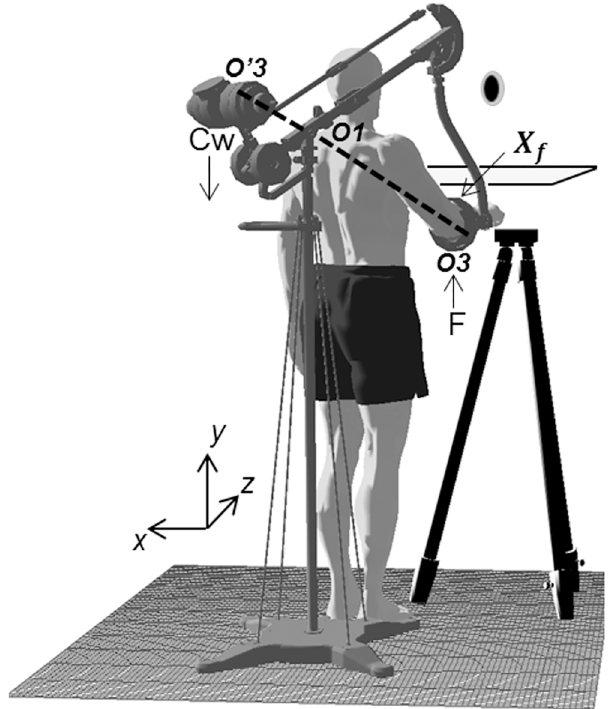
Fig 1. Apparatus. Trackhold (TH) device and subjects ’ arm posture at the moment of force detection, namely when the black sphere (i.e. cursor) was within the gray sphere (i.e., target). Cw represents the load applied on the device balancer. F indicates the consequent upward force exerted on subjects ’ arm ( F = CW /3). Xf is a distance from elbow joint representing the point of force application on subjects arm. O 3 is the contact point between subject ’ s arm and TH (cradle), O1 is the fulcrum of TH horizontal lever arm and O ’ 3 is the center of TH balancer. While in target, mean value of shoulder adduction angles across subjects was 8.3° ± 7°, shoulder flexion angle was 12.3° ± 5.1° and elbow elevation angles was 83.1° ±